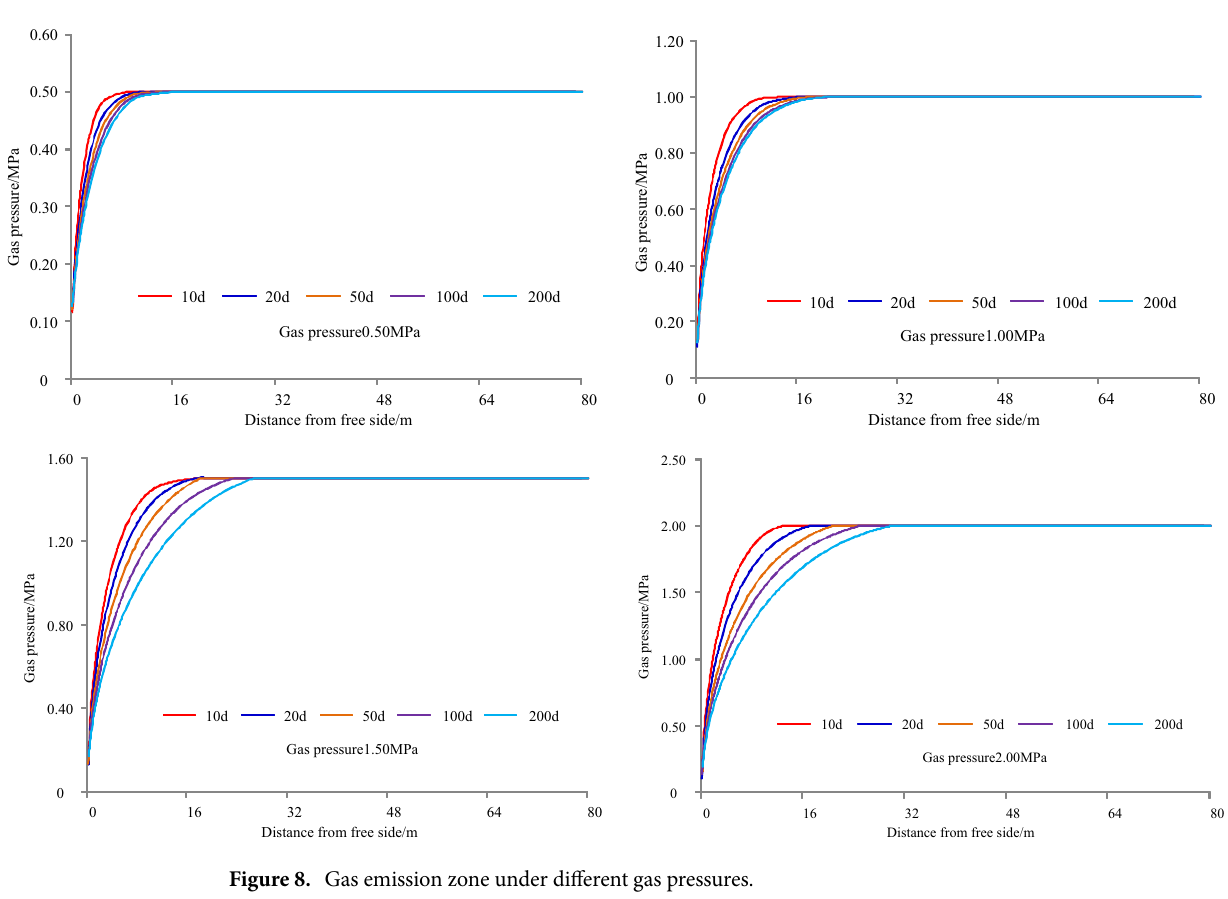
Figure 8. Gas emission zone under different gas